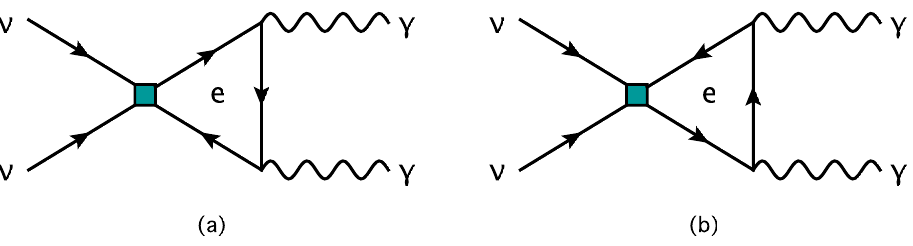
Figure 1 . One-loop Feynman diagrams that induce e(cid:11)ective (cid:23)(cid:13) interactions in equation (4.1) due to e(cid:11)ective (cid:23)e interactions in equation